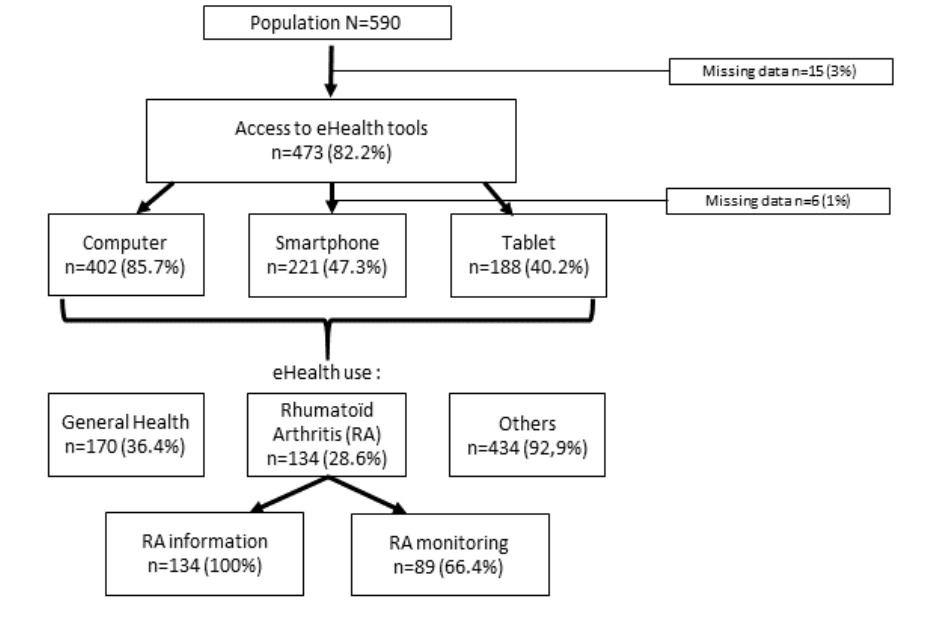
Table 1. Frequency and modalities of use of the internet by study patients using eHealth for rheumatoid arthritis. eHealth